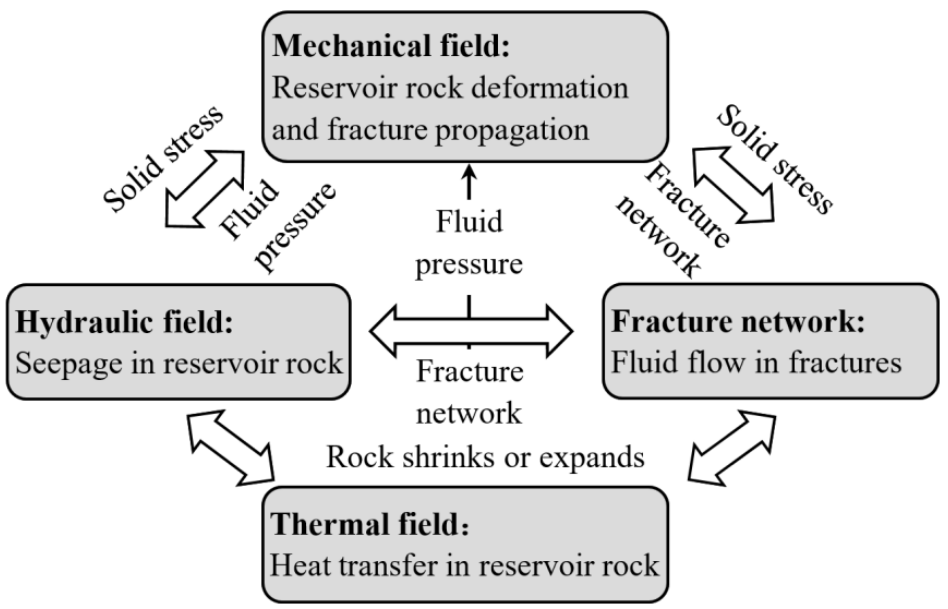
Figure 2. Thermal-hydraulic-mechanical coupling and fracture propagation mechanisms. The staggered coupling scheme is adopted in this study. In hydraulic field, under the current deformation and fracture network of solid rock, the fluid pressures in the pore media of the rock matrix and fractures are computed, and the fluid pressures are transmitted to the rock matrix. In the thermal field, the heat transfer in the pore media of the rock matrix and fracture fluid are computed through the governing equation of the current time, and the heat is transmitted to the rock matrix where it induces thermal stresses. In the mechanical field, the solid deformation and stresses in the pore media of the rock matrix are computed. Furthermore, by introducing the thermal stresses, the final effective stresses can be obtained. Based on the stress states of each finite element, the fracture criterion is used to judge whether the fractures initiate or propagate. In this study, the fracture criterion considering damage evolution is used to simulate the propagation of hydraulic fractures, and the tensile strength σ t and fracture energy G f are involved, the details of which can be found in the related reference